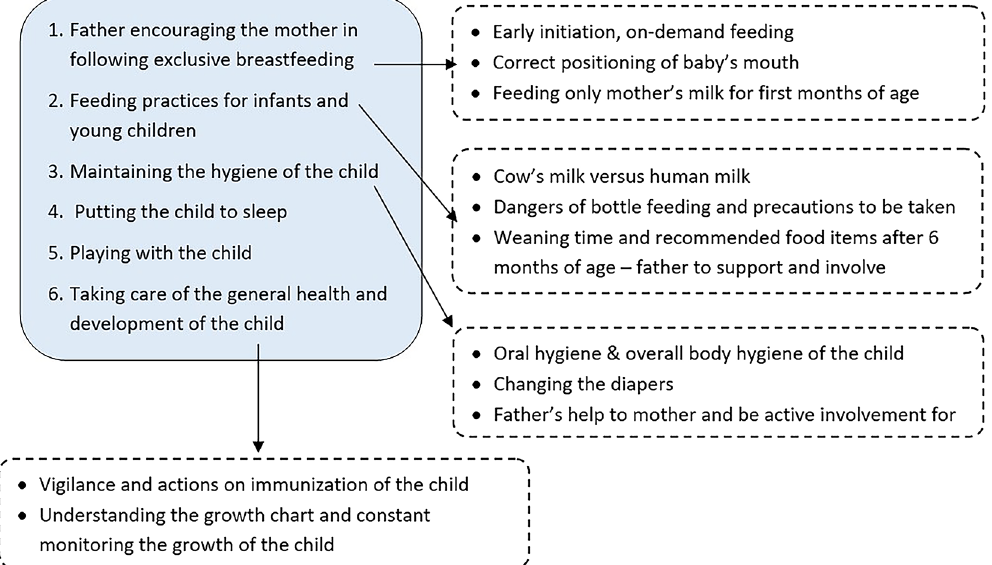
Figure 1. IYCF module